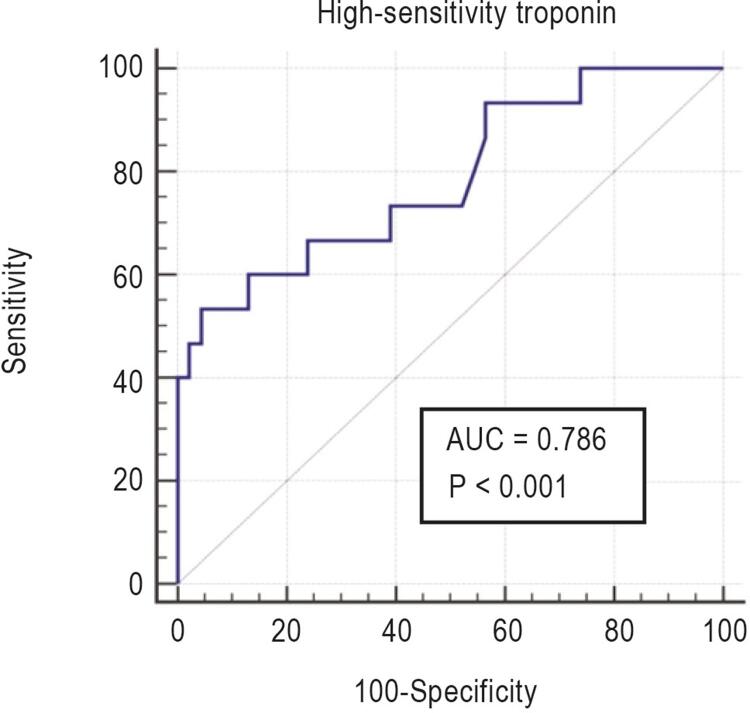
– Prediction of in-hospital mortality based on troponin values. AUC: area under the ROC curve.